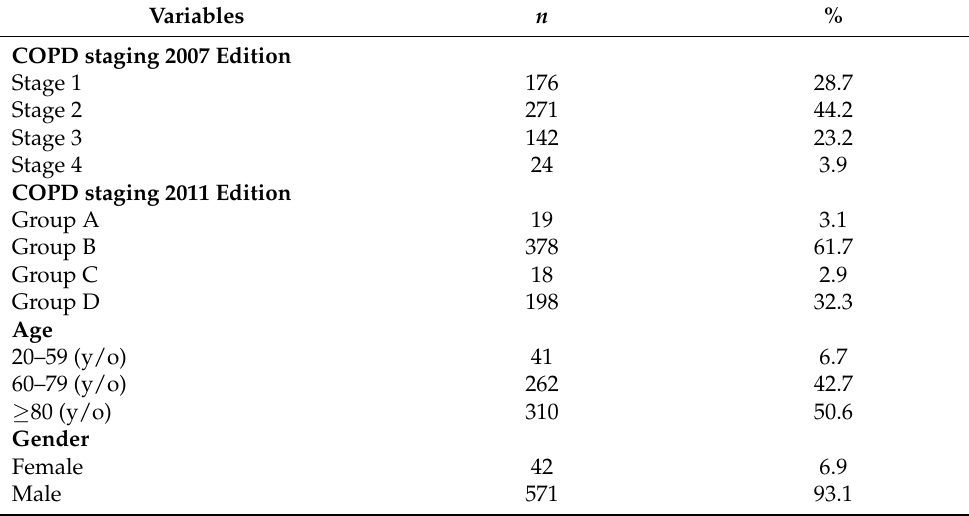
Table 1. Demographic data of COPD patients ( n =